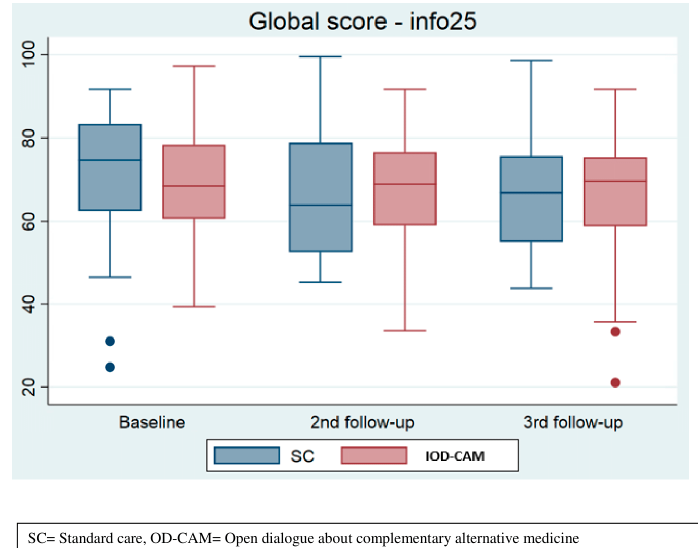
Figure 4. Perceived information.